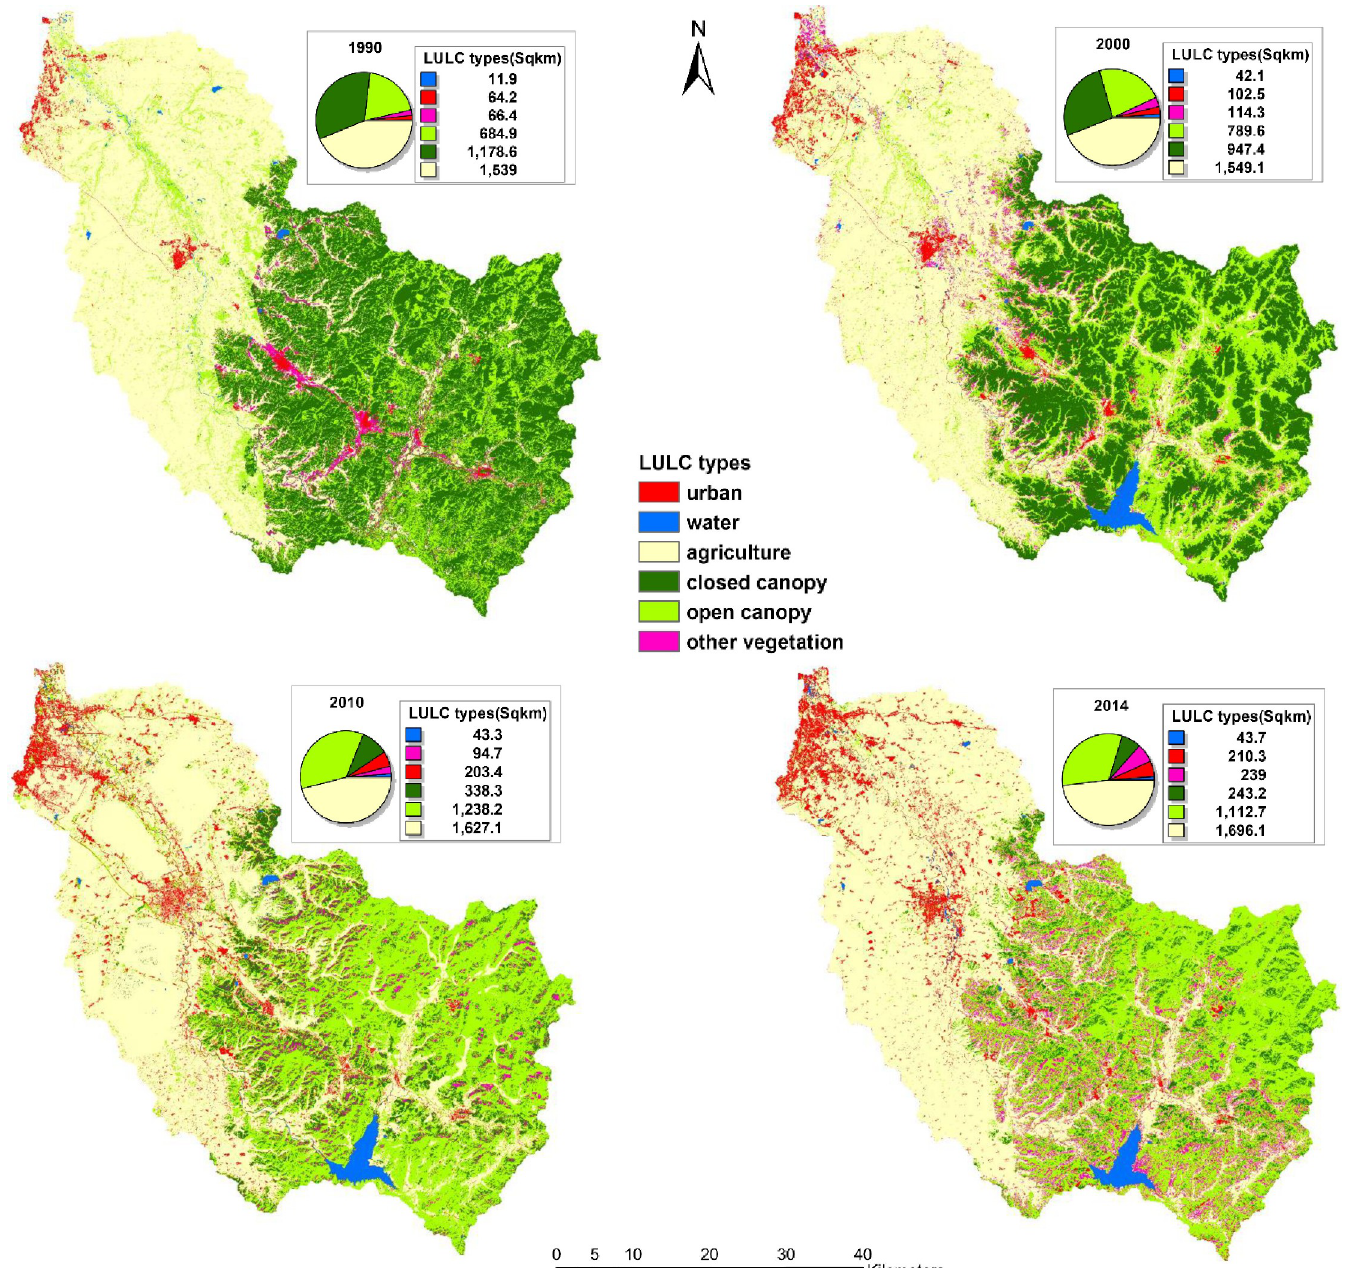
Fig 2. LULC maps of the watershed at four time